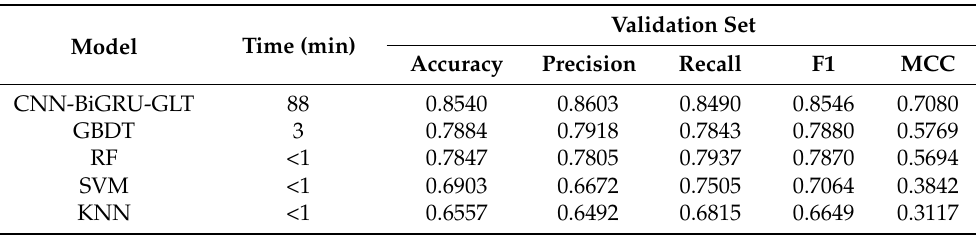
Table 7. Specific metric values of the CNN-BiGRU-GLT model compared to traditional machine learning methods on the validation